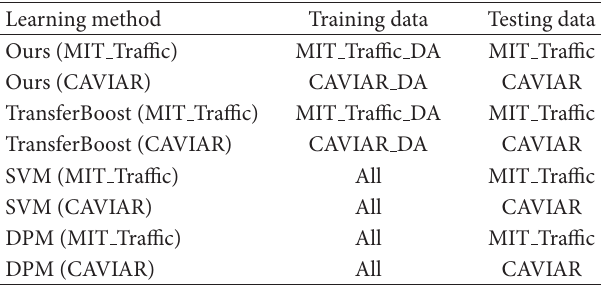
Table 3: The descriptions of learning